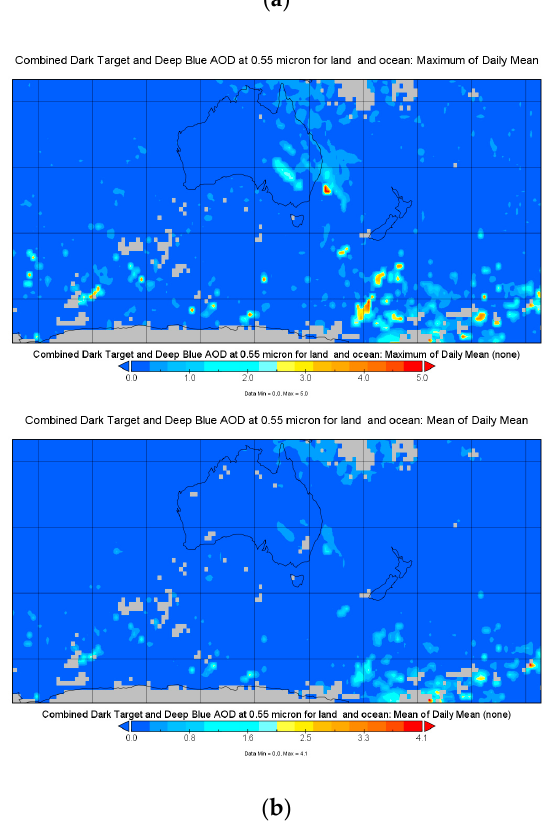
Figure A3. ( a ) Aqua MYD08-E3 maximum and mean of daily mean on land for the period from 10 to 13 February 2019 and ( b ) Aqua MYD08-E3 Combined Dark Target (ocean) and Deep Blue (land) maximum and mean of daily mean for the period from 10 to 17 February